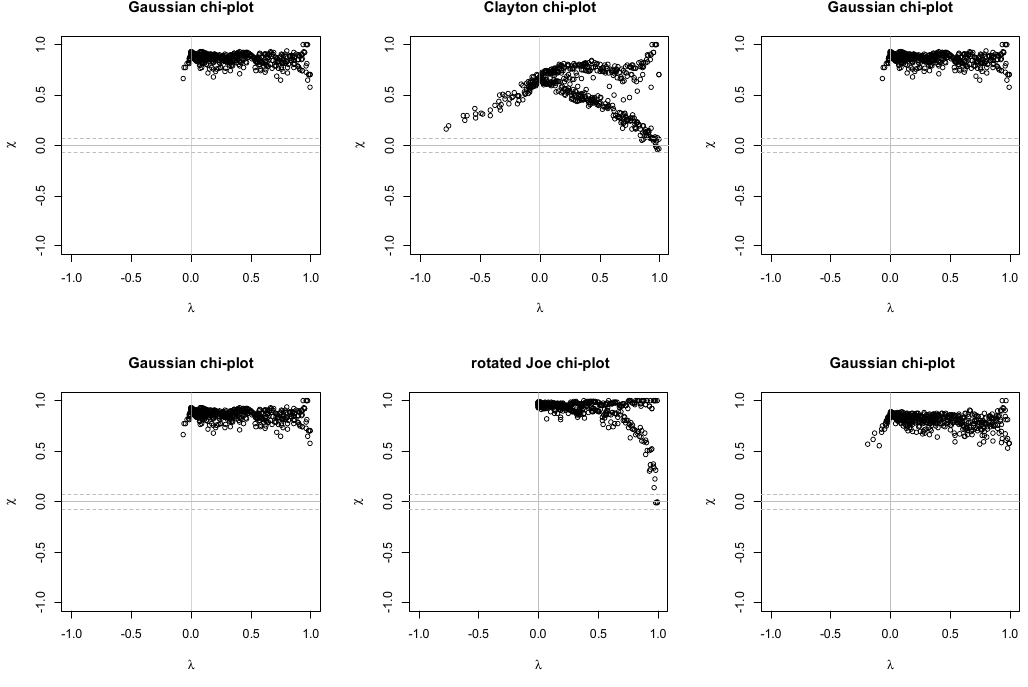
Figure 6. Chi-plots of pair flood volume variables of Zhangjiashan and Xianyang.